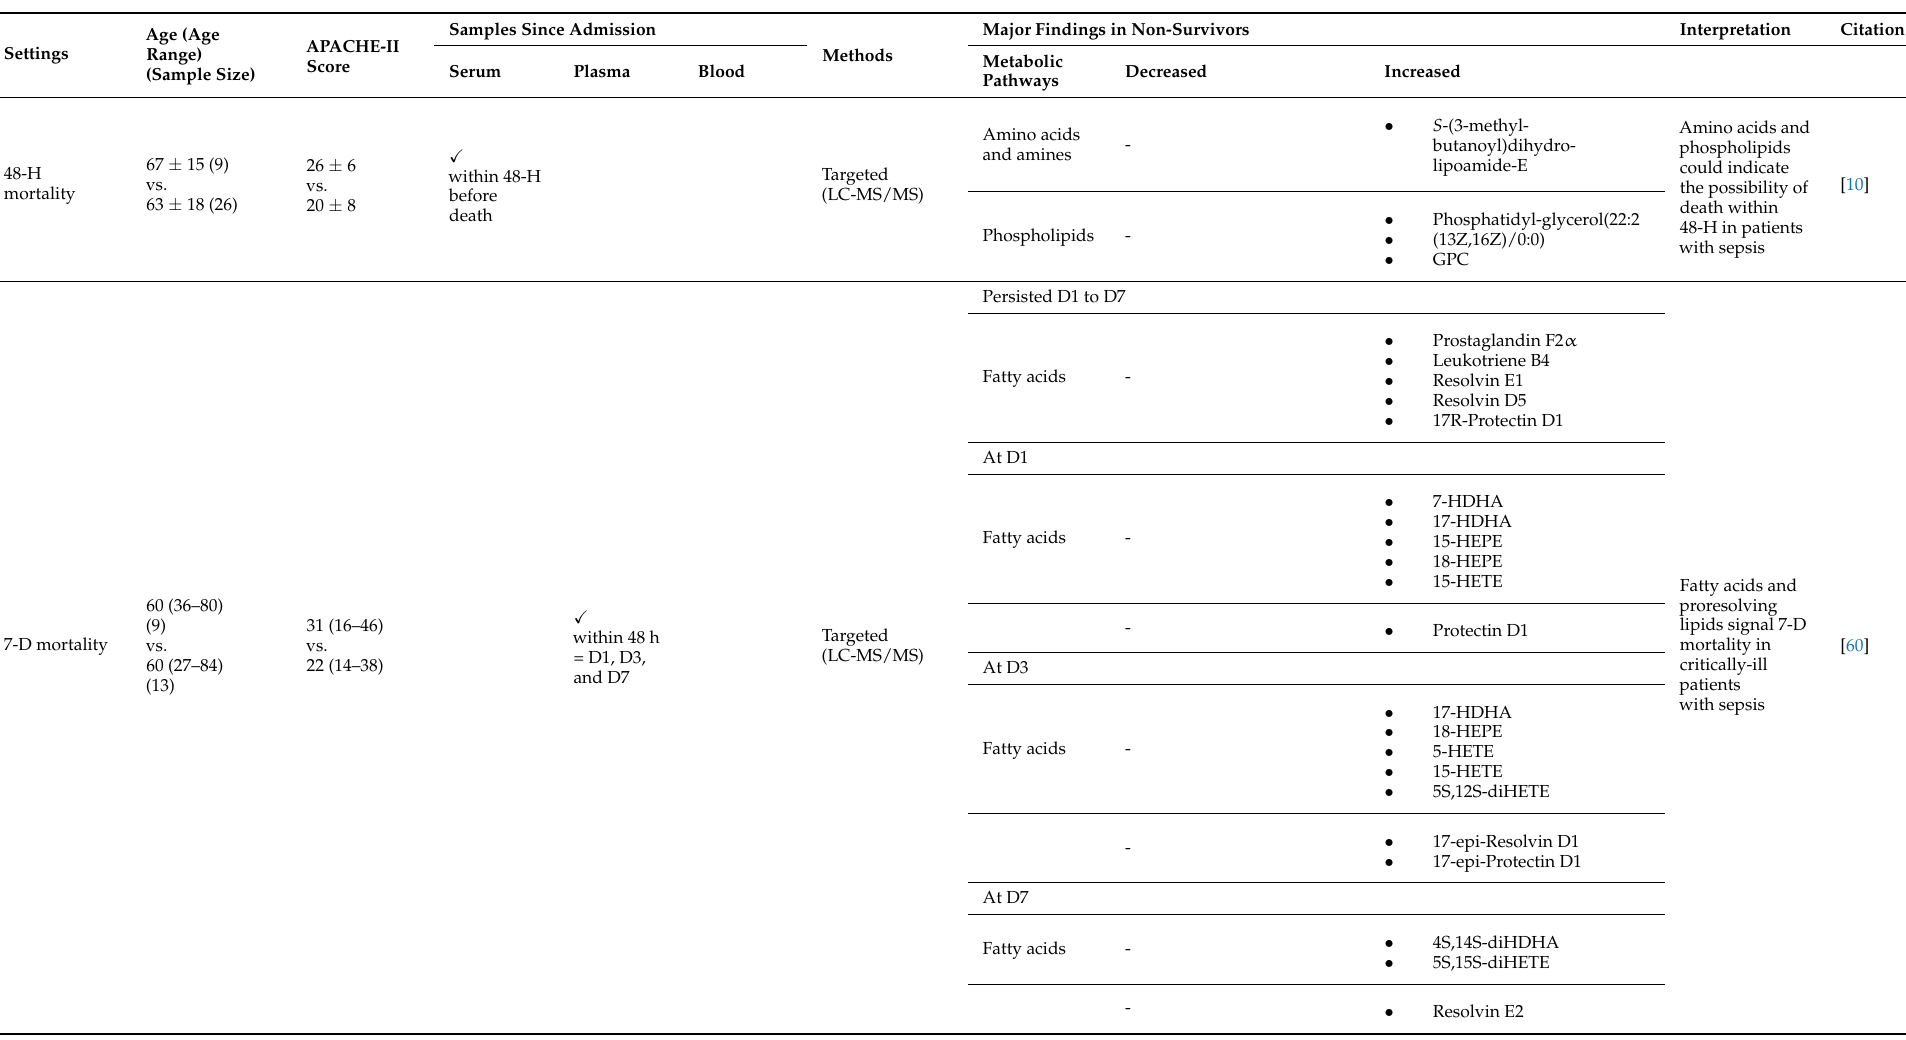
Table 3. Metabolomics-assisted prognostication of patients with sepsis